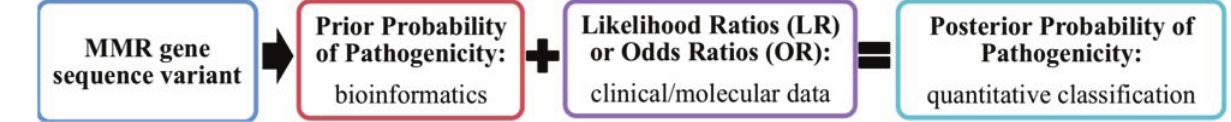
Figure 1. Outline of the mismatch repair genes (MMR) multifactorial likelihood